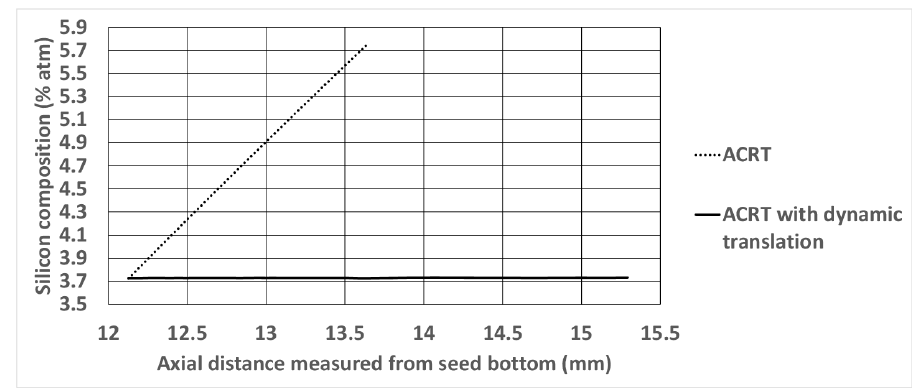
Figure 6. Variation of the axial crystal composition at the centerline after the initiation of dynamic translation (t = 5 h).